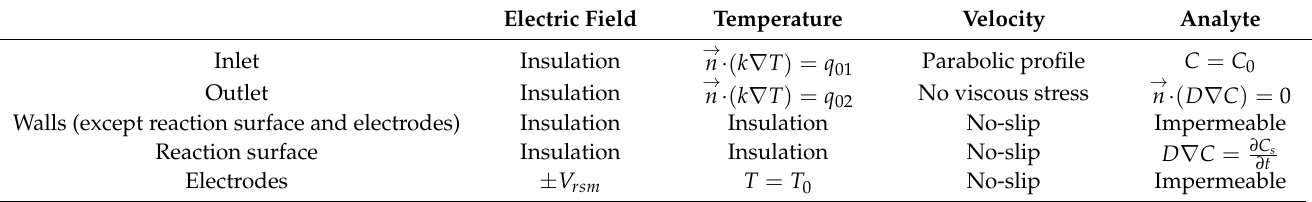
Table 3. Boundary conditions used in this